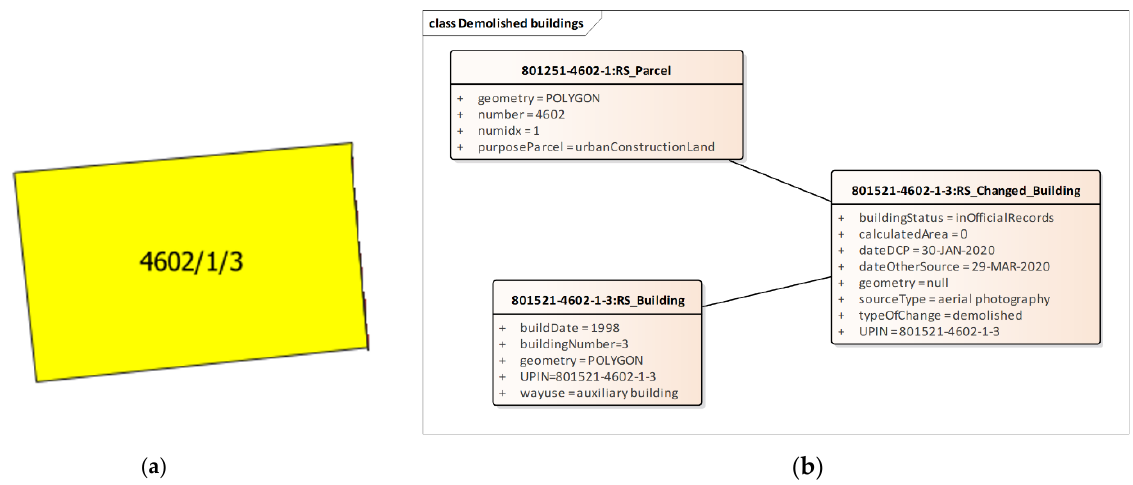
Figure 28. ( a ) Building in the official records. ( b ) An instance diagram of the detected demolished building.